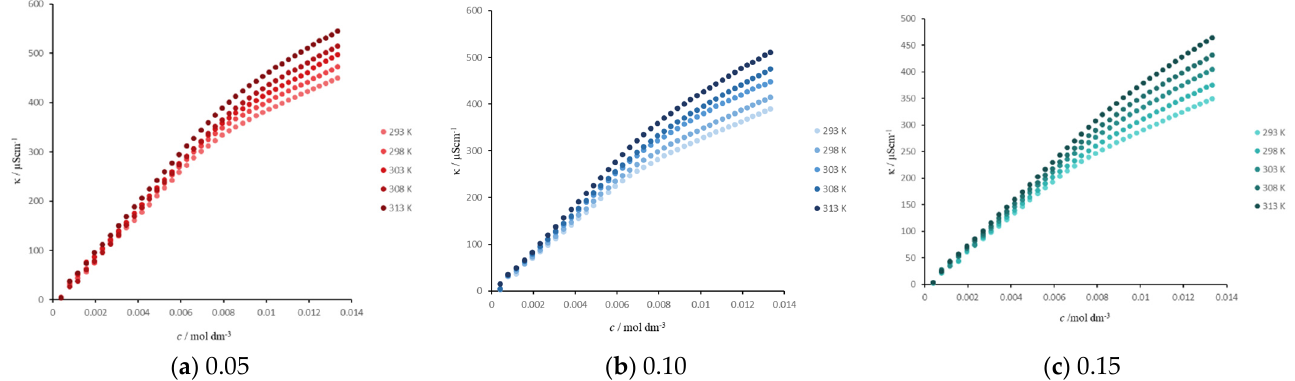
Figure 1. Plot of electrical conductivity vs. concentration for SDS in the binary mixture of water–propane-1,2-diol at different temperatures, where the mass fraction of propane-1,2-diol is equal to ( a ) 0.05, ( b ) 0.10 and ( c ) 0.15.